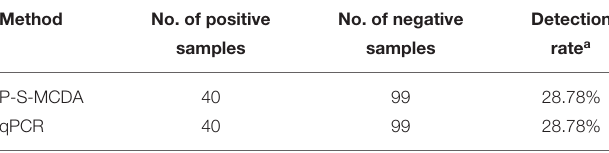
TABLE 2 | Detection of PCV3 in clinical samples by the P-S-MCDA and qPCR.